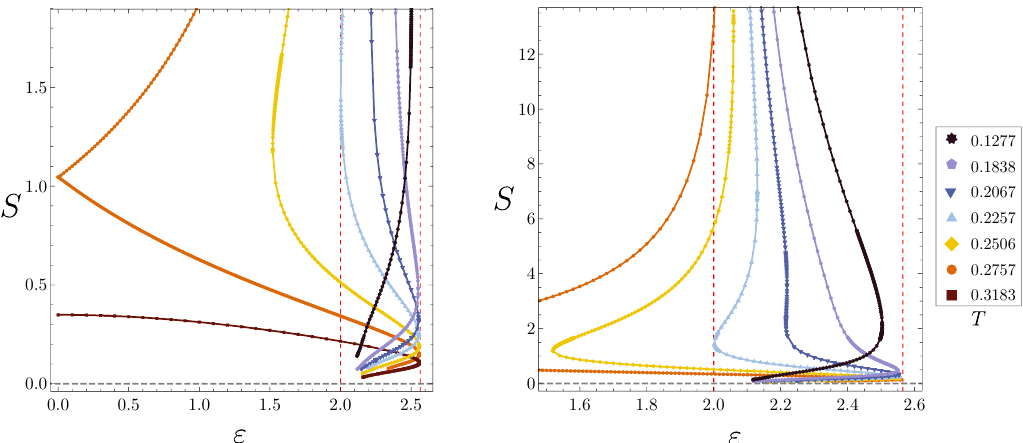
Figure 7 . Left : entropy against the boundary parameter for low temperature black holes with ’ 0 : 2757. The orange disks show black holes with T ’ T Schw . The brown squares show T < T Schw min min the (hot) small black holes with T = 1 =(cid:25) for reference. As we lower the temperature, the large black holes begin to exist for " > 2. Right : the asymptotic behavior of isothermal entropy curves. Both solution branches approach " = 2, with the large branch having a steeply increasing S , and the small branch having S ! 0. The red gridlines show " = 2 and " = " c